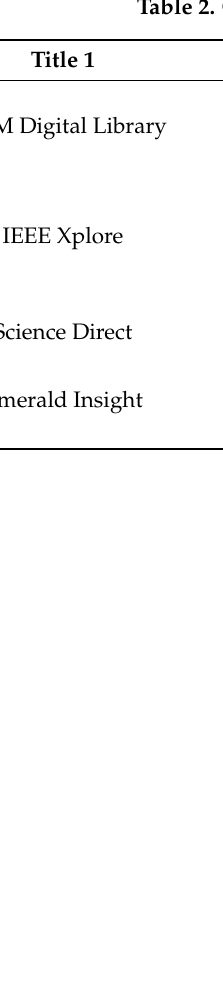
Table 2. Queries by digital library for real-time related open (government) data studies.